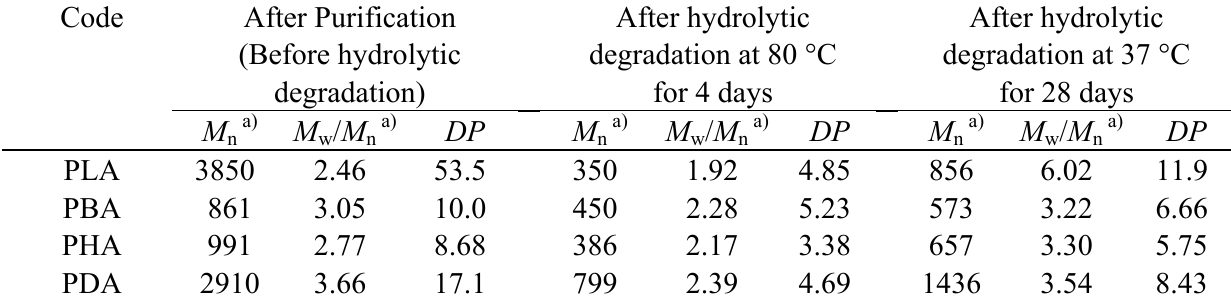
Table 2. M , M / M , and DP of PLA, PBA, PHA, and PDA after hydrolytic degradation at n w n 80 °C for 4 days and at 37 °C for 28 days.